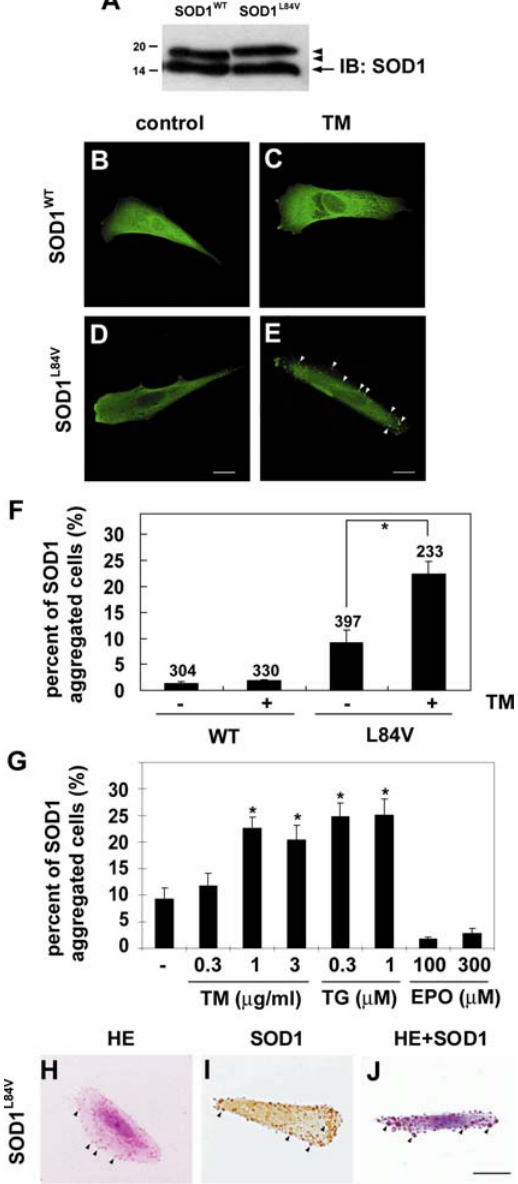
Figure 1. Eosinophilic aggregates of L84V SOD1 are induced by ER stress. ( A ) Western blotting analysis of the expression of SOD1 in SK-N- SH cells, which stably expressed FLAG tagged wild-type SOD1 or L84V mutant SOD1. Arrowheads and arrow indicate exogenous and endogenous SOD1, respectively. ( B–D ) Immunofluorescent analysis of SOD1 aggregates in SK-N-SH cells expressing wild-type SOD1 ( B, C ) or L84V SOD1 ( D, E ). Cells were incubated under control conditions ( B, D ) or with 1 m g/ml tunicamycin ( C, E ) for 24 h, and then were fixed and stained with an anti-SOD1 antibody. Tunicamycin induced aggregates of SOD1 (arrowheads) in L84V SOD1-expressing cells, but not in wild- type SOD1-expressing cells. Scale bar=20 m m. ( F ) Quantification of (B- D). After the staining the cells with SOD1 aggregates were counted and scored. Numbers indicate the amounts of total counted cells. Asterisks show a significant difference from control, *p , 0.001. ( G ) SOD1 aggregates induced by tunicamycin and thapsigargin, but not by etoposide. SK-N-SH cells expressing L84V SOD1 were exposed to 0.3, 1 and 3 m g/ml tunicamycin, 0.3 and 1 m M thapsigargin and 100 and 300 m M etoposide. Asterisks show a significant difference from control, *p , 0.001. ( H-J ) Eosinophilic SOD1 aggregates induced by tunicamycin. Cells were treated as described in ( E ) and then stained with HE ( H ), anti- SOD1 antibody ( I ), or both ( J ). Scale bar=20 m m.